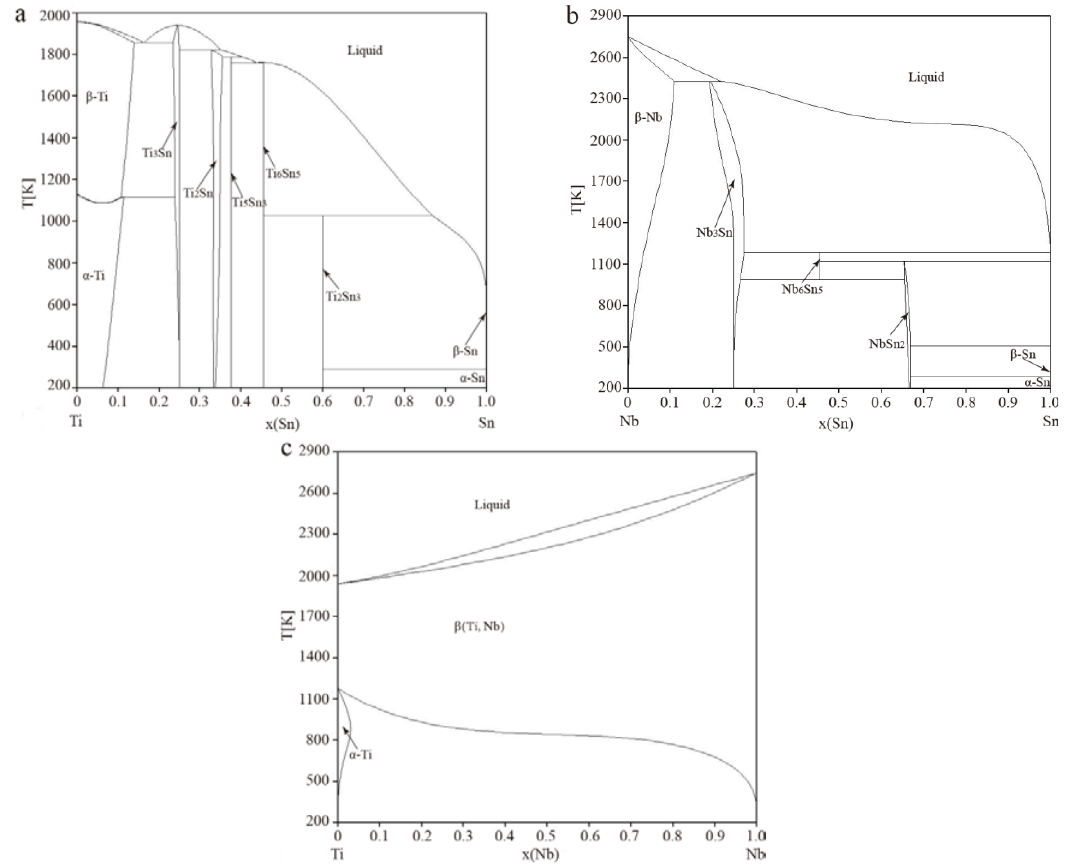
Figure 1. The binary phase diagrams: ( a ) Ti-Sn; ( b ) Nb-Sn; ( c ) Ti-Nb.